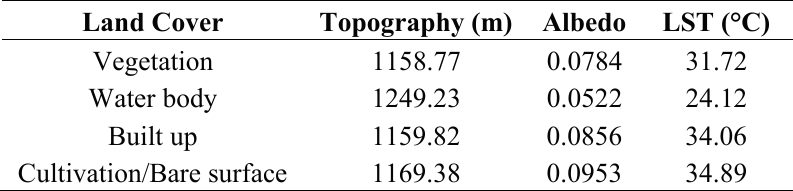
Table 9. Mean topography, mean albedo and mean LST across land cover types in Barakinladi in 2014. Land